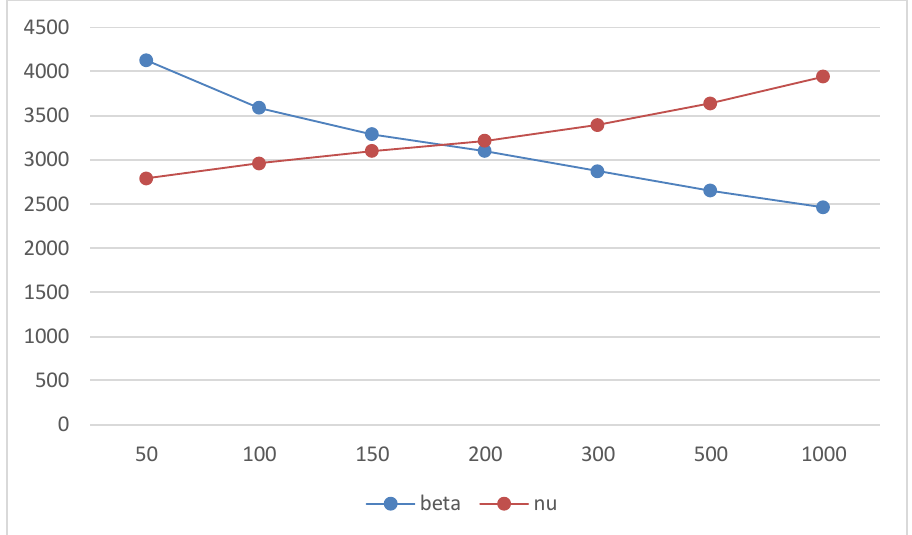
Fig. 9. Values of P under alteration of β and υ for the centralized